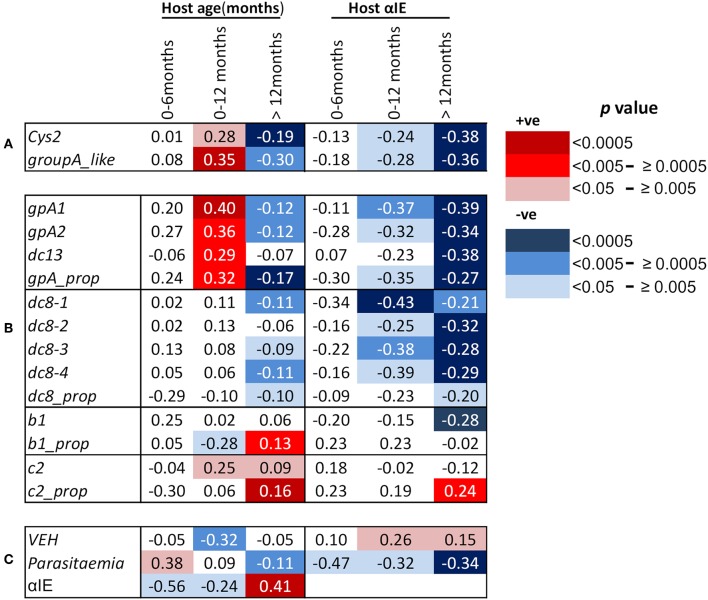
Correlations between host age in months, host antibodies to infected erythrocytes (αIE) and var gene expression of the infecting parasites. Shown are Spearman's rank correlation coefficient (rho) for the associations between host age, host antibodies to IE (αIE), and expression of var genes of the infecting parasites in children aged 0–6, 0–12, and above 12 months. Red background shading indicate positive correlation while blue shading indicate a negative correlation. Increasing color intensity indicates increasing statistical significance of the correlation as indicated in the key [p < 0.00005 (darkest), p < 0.05 (lightest)]. (A) Associations of age of the children and their αIE levels with expression of cys2 and group A-like var genes, (B) associations of age of the children and their αIE levels with var transcript quantity obtained with primers targeting (i) group A var genes (gpA1, gpA2, dc13) and their proportion relative to the sum of the var transcript measured (gpA_prop), (ii)DC8 var genes (dc8-1, dc8-2, dc8-3, and dc8-4) and their proportional expression (dc8_prop), (iii) group B var genes (b1) and their proportional expression (b1_prop), and (iv) group C var genes (c2) and their proportional expression (c2_prop), (C) associations of age of the children and their αIE levels with var gene expression homogeneity (VEH). Also shown is the associations of parasitemia with age and αIE levels of the children and the relationship between αIE and age of the children. More details about the primers can be found in Table S1.